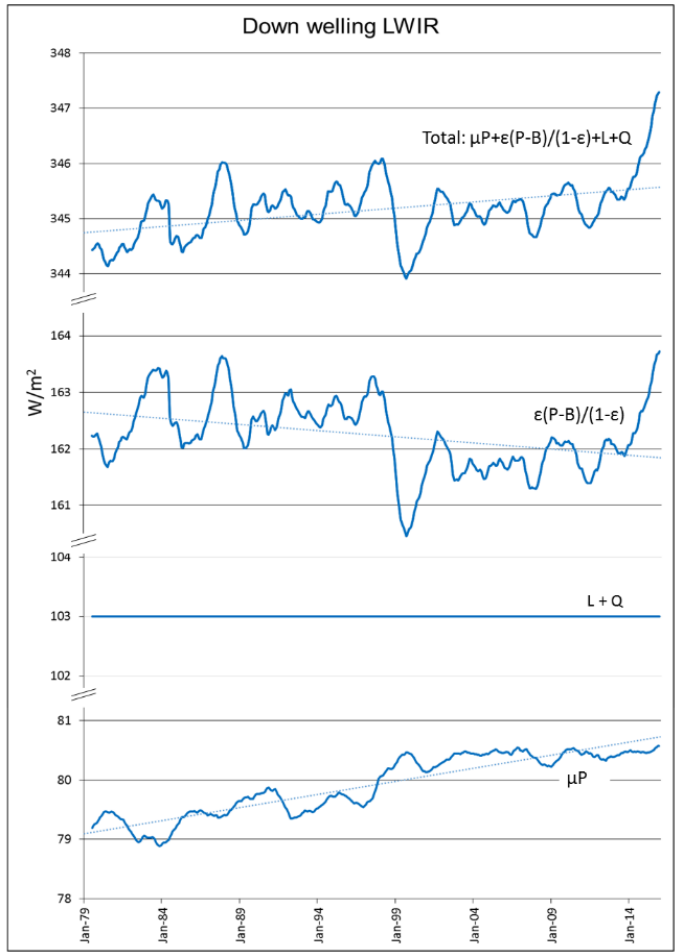
Figure 10. Components of downwelling longwave radiation, 1979–2015. µ P is atmosphere-absorbed solar re-emitted as longwave down; ε ( P − B ) / ( 1 − ε ) is back radiation; L + Q is rate of transfer of latent and specific heat into the atmosphere. Center-averaged 12-monthly values. Blue dotted lines are trend lines. Uncertainty ranges not shown. All of the units are in W/m 2 . Another feature of the model is that outgoing radiation is sourced entirely from the surface emission; the only route for absorbed solar energy to leave the system is by re-emission from the surface. This is a direct consequence of the non-radiating top of atmosphere, which prevents the atmosphere from radiating directly to space.